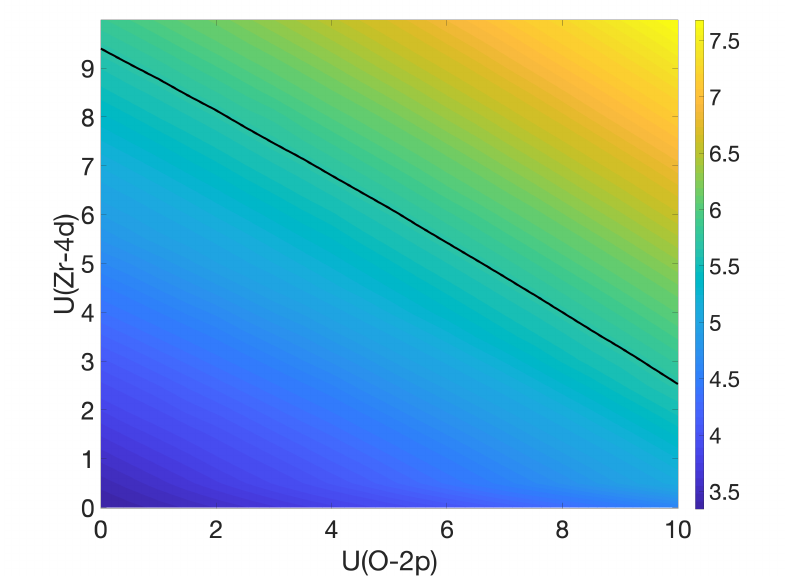
Figure 2. Calculated band gap of c-ZrO 2 as a function of the Hubbard-U parameters. The black line indicates the experimental band gap of 5.7